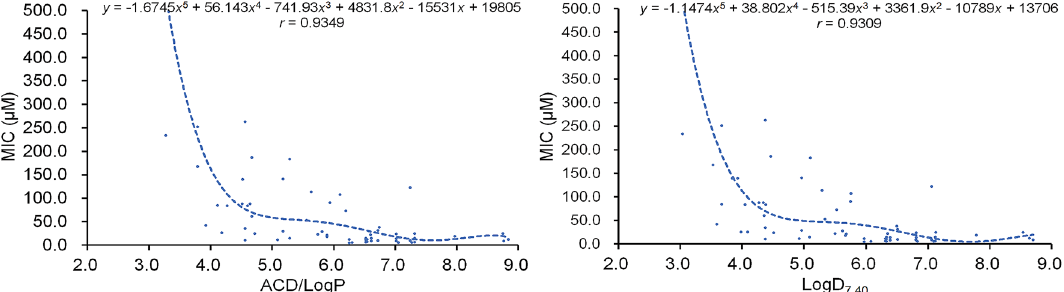
Figure 7. Polynomial regression analyses for the physicochemical parameters ACD/LogP or LogD 7.40 ( x ) and the average MICs ( y ) to gram-positive bacteria including S. aureus , S. epidermidis , or/and B. subtilis , of compounds 1 to 66